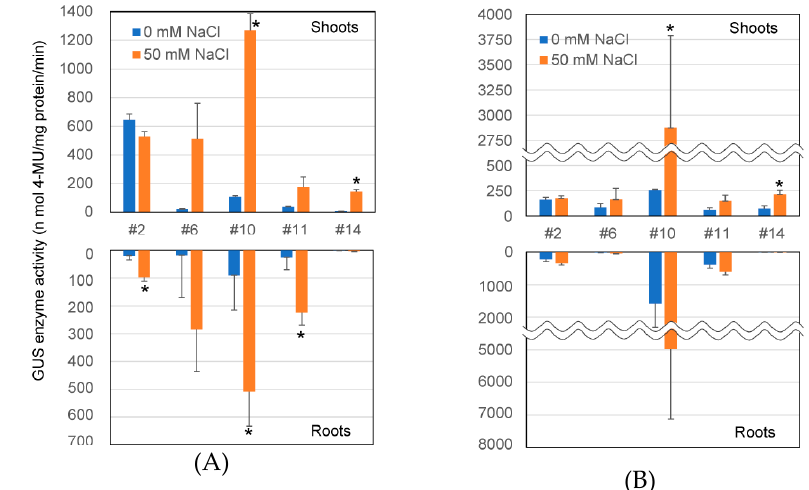
Figure 2. Transcriptional level of GUS gene in transgenic plants. ( A ) Seven-day-old seedlings; ( B ) plants at reproductive stage (four weeks old). RNA was extracted from the shoots and roots of transgenic plants grown on 1/2 MS agar medium, followed by incubation on 50 mM NaCl agar medium for 24 h and used for qRT-PCR. The expression levels of the ubiquitin extension protein were used for normalization of GUS expression. Expression levels are shown relative to that in the roots of Line 14 at the seedling stage under 0 mM NaCl (1.0). Data are presented the mean ± SE ( n = 3, biological replicates). Single and double asterisks denote significant differences compared with values of plants at 0 mM NaCl treatment at p < 0.05 and p < 0.01, respectively, determined using Student’s t -test.